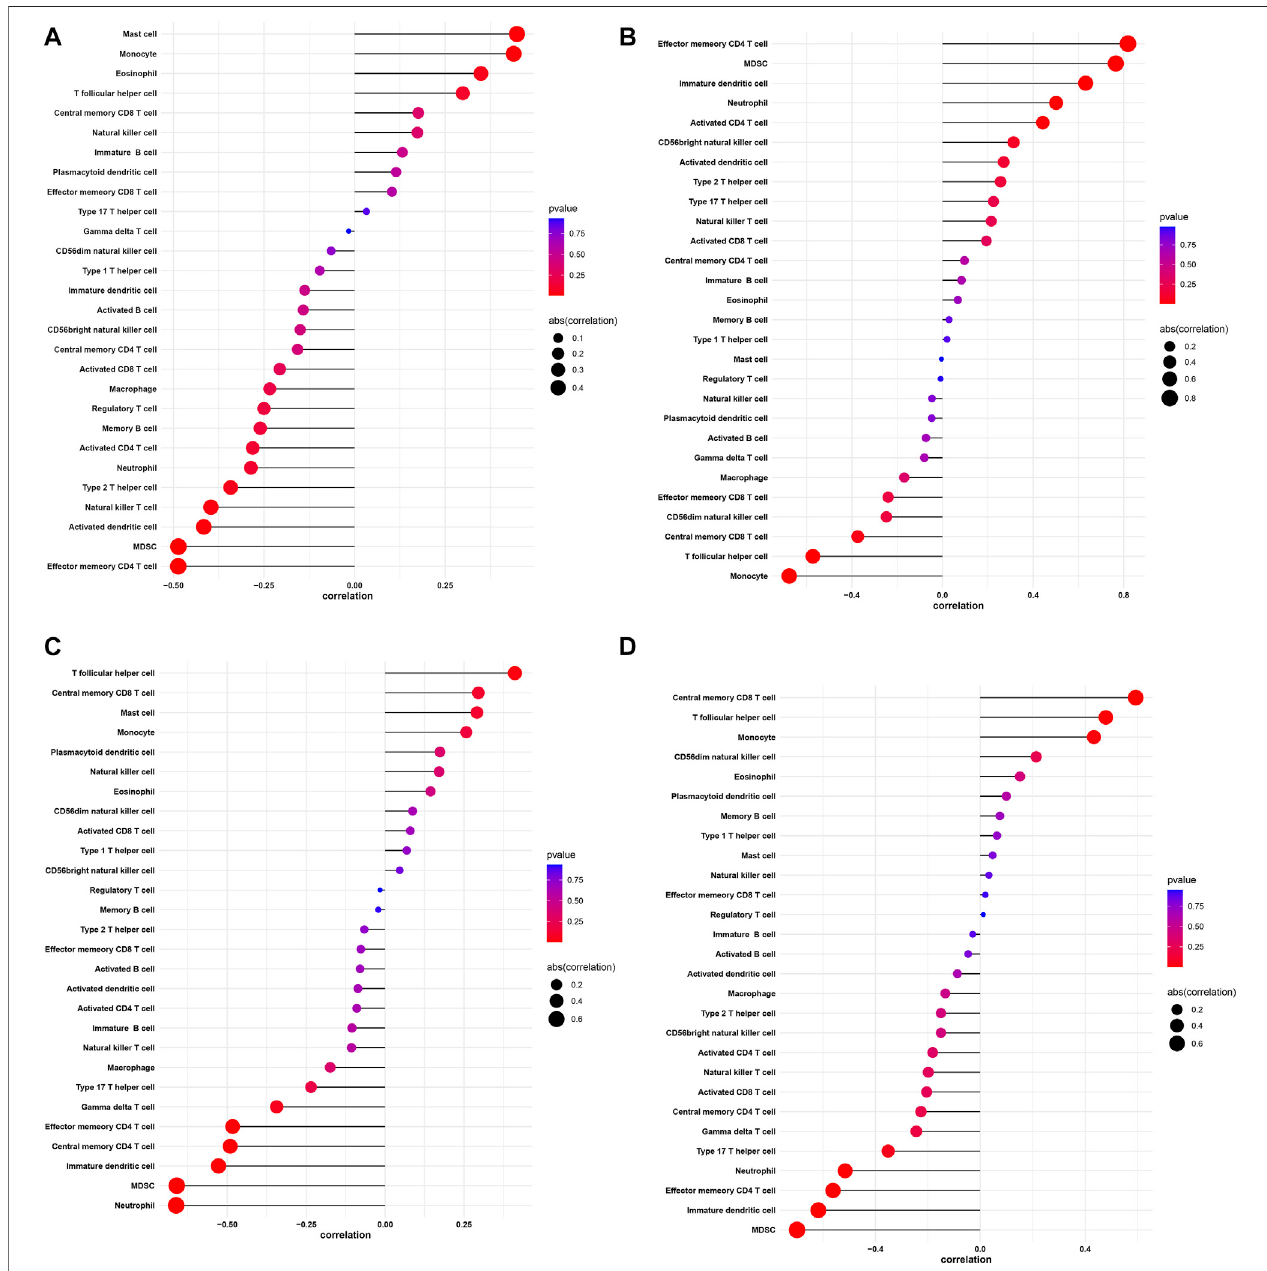
FIGURE 10 | Correlation between DAAM1, SDC4, STC2, NOX4 and in fi ltrating immune cells. (A) Correlation between DAAM1 and in fi ltrating immune cells. (B) Correlation between SDC4 and in fi ltrating immune cells. (C) Correlation between STC2 and in fi ltrating immune cells. (D) Correlation between NOX4 and in fi ltrating immune cells. The size of the dots represents the strength of the correlation between genes and immune cells; the larger the dots, the stronger the correlation, and the smaller the dots, the weaker the correlation. The color of the dots represents the p -value, the redder the color, the lower the p -value, and the bluer the color, the larger the p